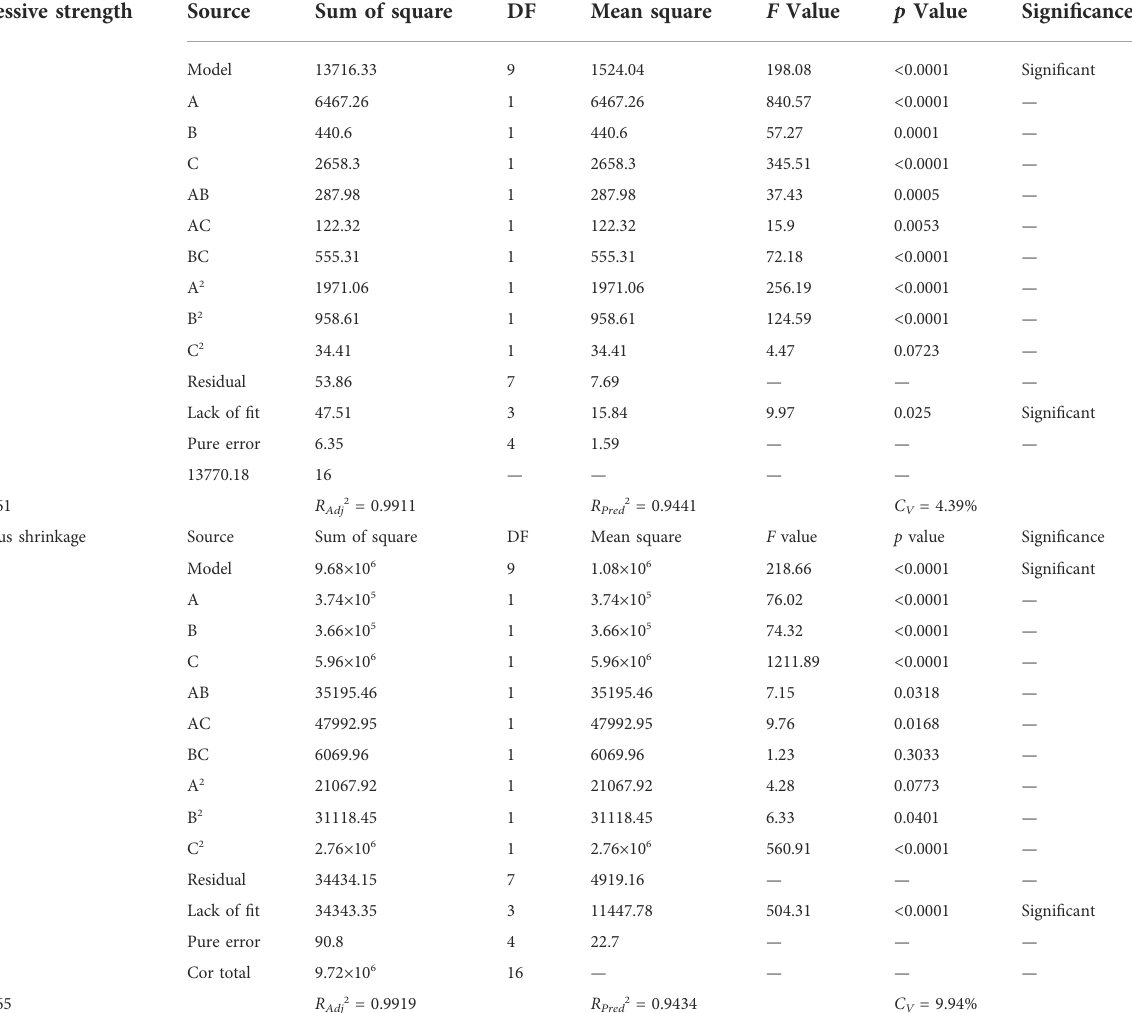
TABLE 4 ANOVA of response surface regression model. Compressive